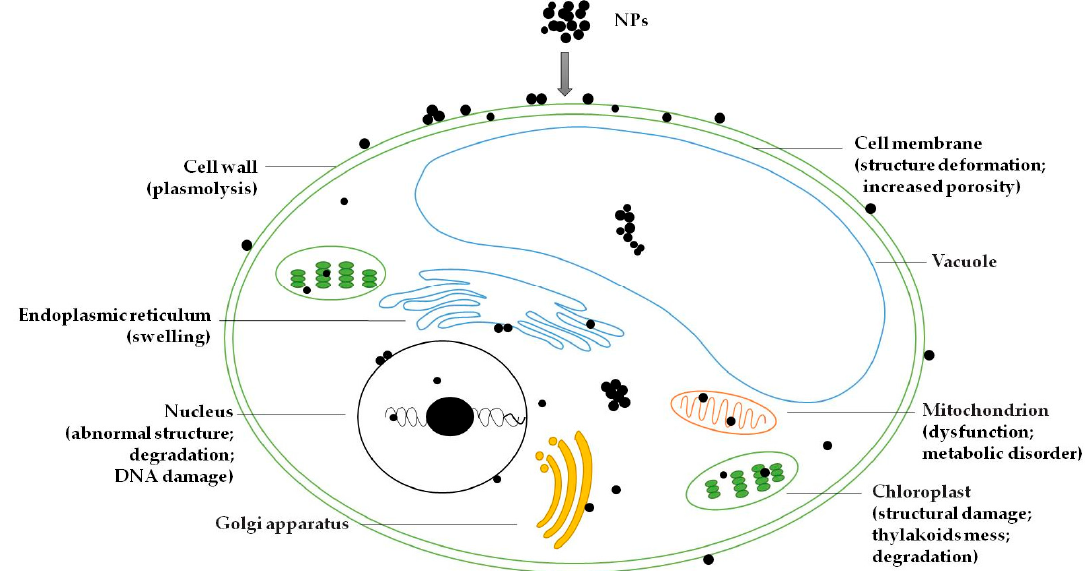
Figure 1. Possible distribution and potential toxic outcomes of NPs in algal cell.